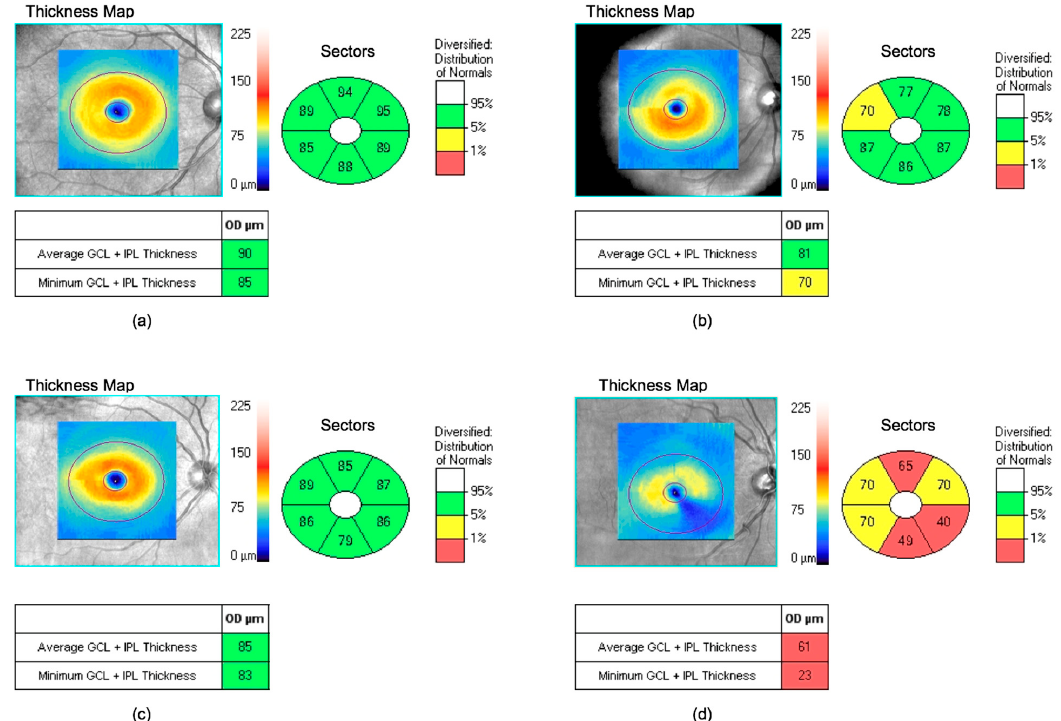
Figure 1. Ganglion cell layer (GCL) measurements by spectral-domain optical coherence tomography: